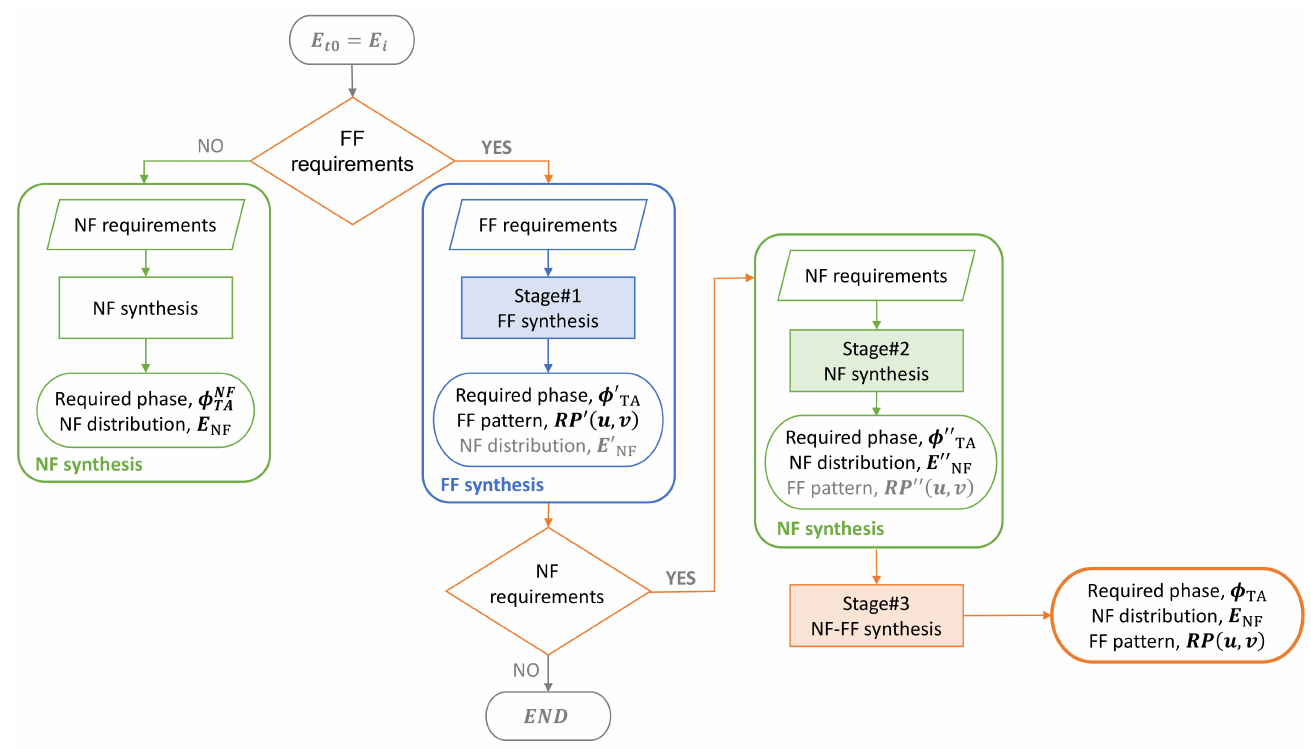
Figure 2. Flowchart of the general synthesis